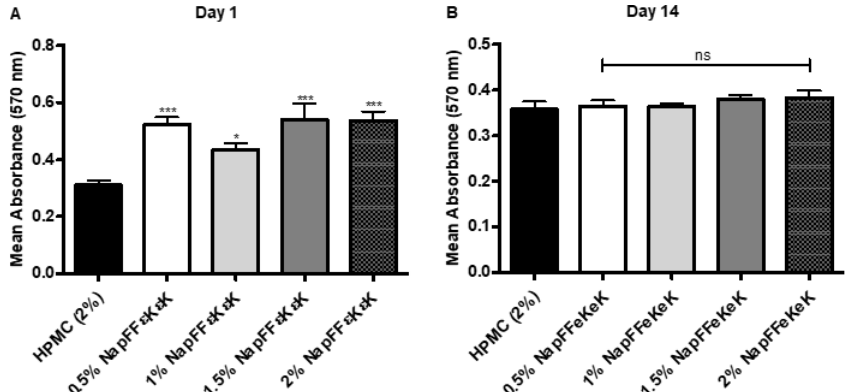
Figure 1. Formulated NapFF ε K ε K ‐ OH hydrogel properties. ( A ) The assembled NapFF ε K ε K ‐ OH hydrogels (0.5–2% w / v ) were shown to be self ‐ supporting. ( B ) Confocal microscopy of DPSCs 24 h after their encapsulation in 0.5–2% w / v NapFF ε K ε K ‐ OH hydrogels, showed that cells were re ‐ tained in 3D within the hydrogels. Cells were fixed and permeabilised within the hydrogel before staining of the encapsulated DPSC nuclei with DAPI. Images were captured using an SP8 Confo ‐ cal Microscope. Scale bar: 100 μ m.